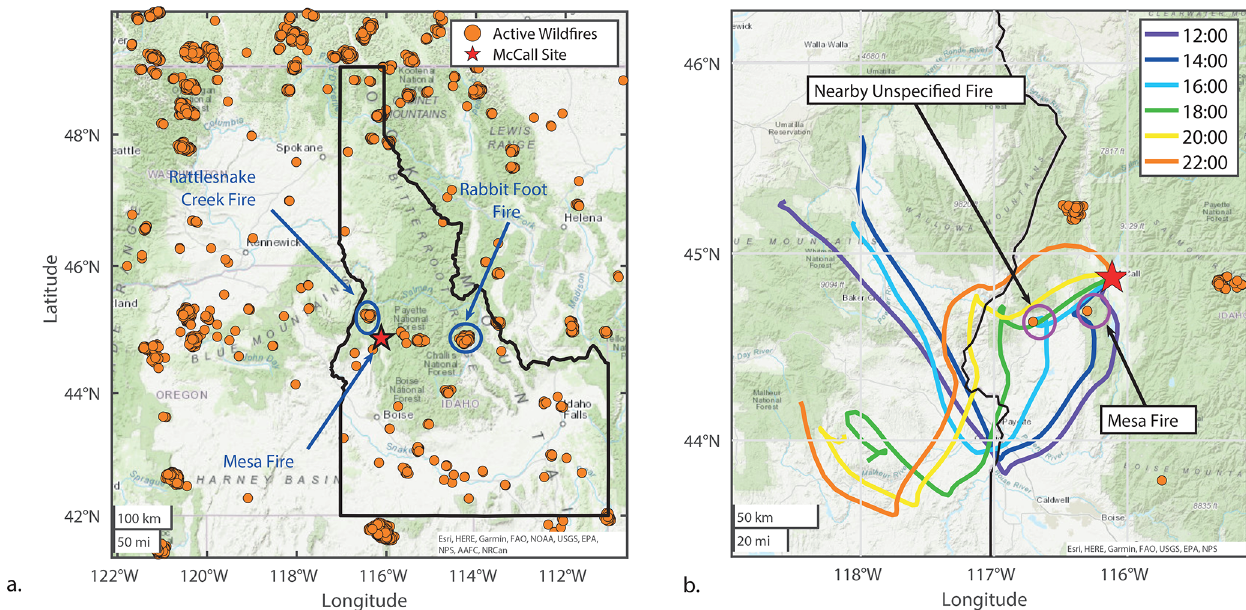
Figure 1. The McCall, Idaho, site is indicated by the red star, and wildfire locations are indicated by orange circles. Panel (a) shows detected wildfires between 15 and 24 August 2018. Panel (b) includes bihourly HYSPLIT back trajectories for the representative smoke impacted day of 17 August. Shown here are active wildfires of 15 through 17 August, as back trajectories end 24h back. Fire locations were retrieved using the NOAA Hazard Mapping System (HMS) (NOAA,